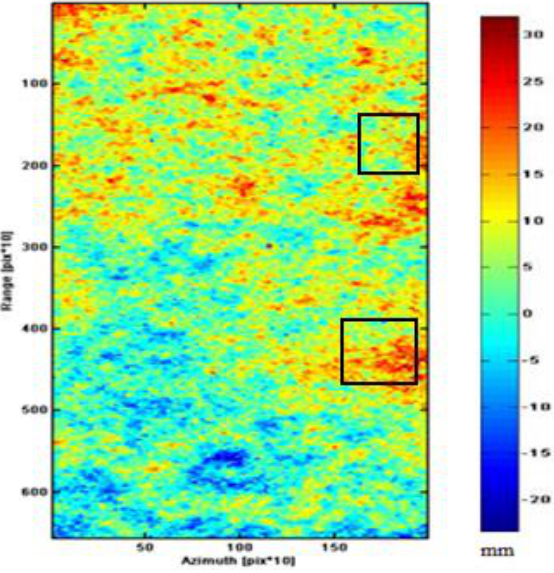
figure 22. The coherence (0.2 to 0.35) is low in mangroves (White Rectangle). Coherence values are as high has 0.58 to 0.75 in the villages within the InSAR data product. The coherence in agricultural fields ranges from low to medium, i.e. from 0.15 to 0.38.